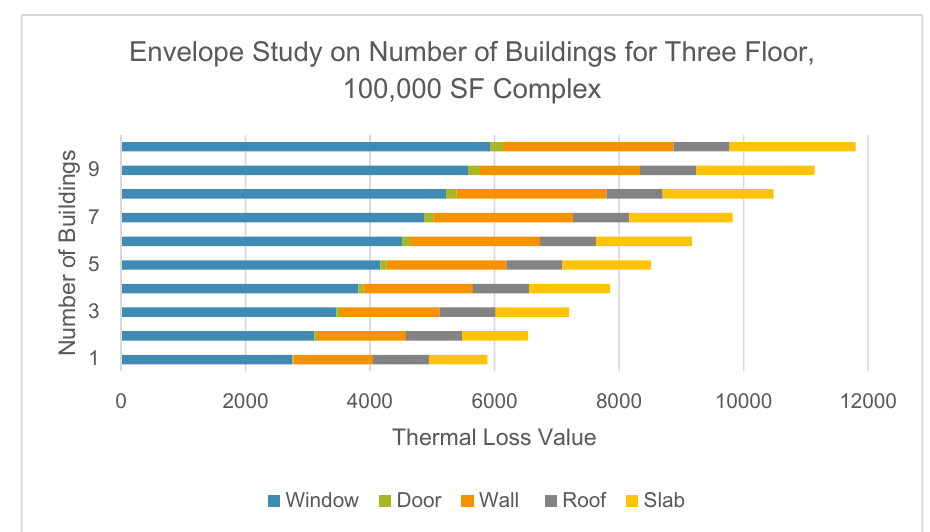
Figure 6. Study of Thermal Loss value by Number of Buildings with Height and Width Constant.